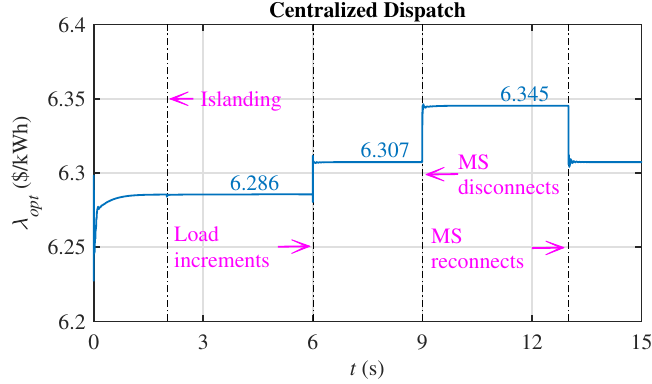
Figure 15. Incremental costs of DGUs.